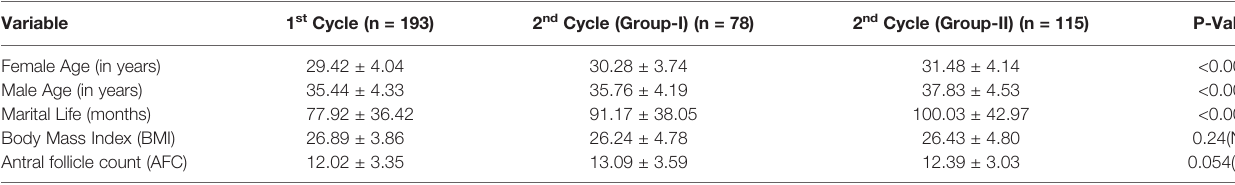
TABLE 1 | Basal characteristics of the fi rst and second cycle. Variable 1 st Cycle (n = 193)